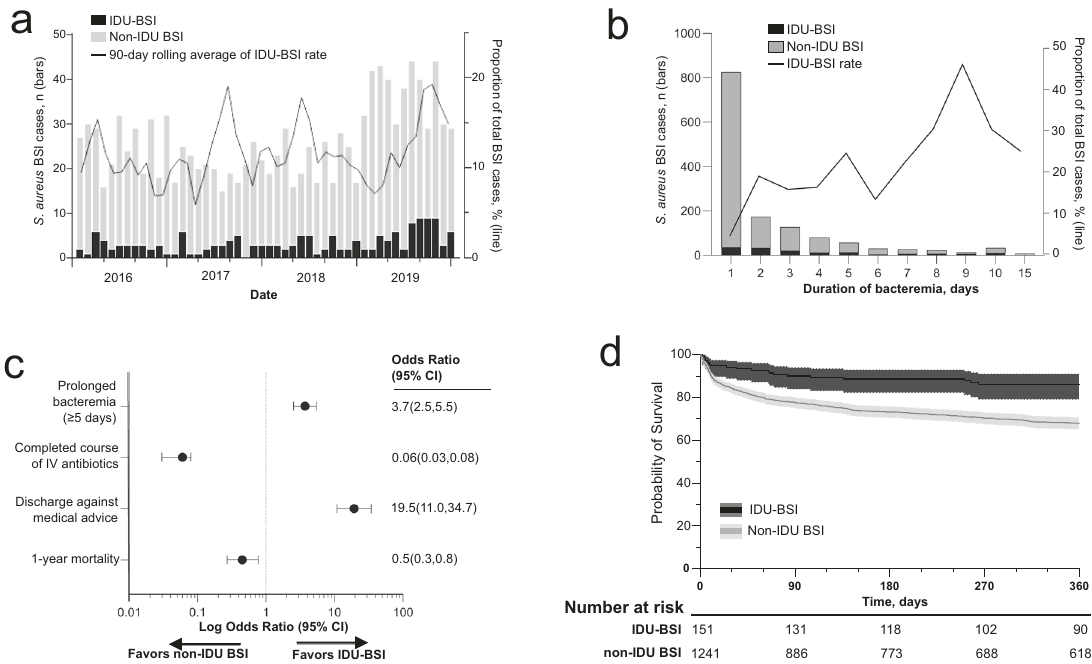
Fig. 2 Comparing the clinical traits and IDU-BSI and non-IDU BSI. a Number of unique patients with S. aureus IDU-BSI and non-IDU BSI (bars), and 90- day rolling average proportion of total BSI cases that are IDU-associated (line) identi fi ed in BJH from 1/1/2016 to 12/31/2019. b Duration in days of S. aureus bacteremia among adults strati fi ed by IDU-BSI and non-IDU BSI. c Among BSI cases, AMA discharges and prolonged bacteremia ( ≥ 5 days) was more common among IDU-BSI with lower rates of completion of standard of care intravenous (IV) antibiotics but did not translate into higher 1 year mortality rates. d Kaplan – Meier survival curves comparing S. aureus IDU-BSI and non-IDU BSI with number at risk below the